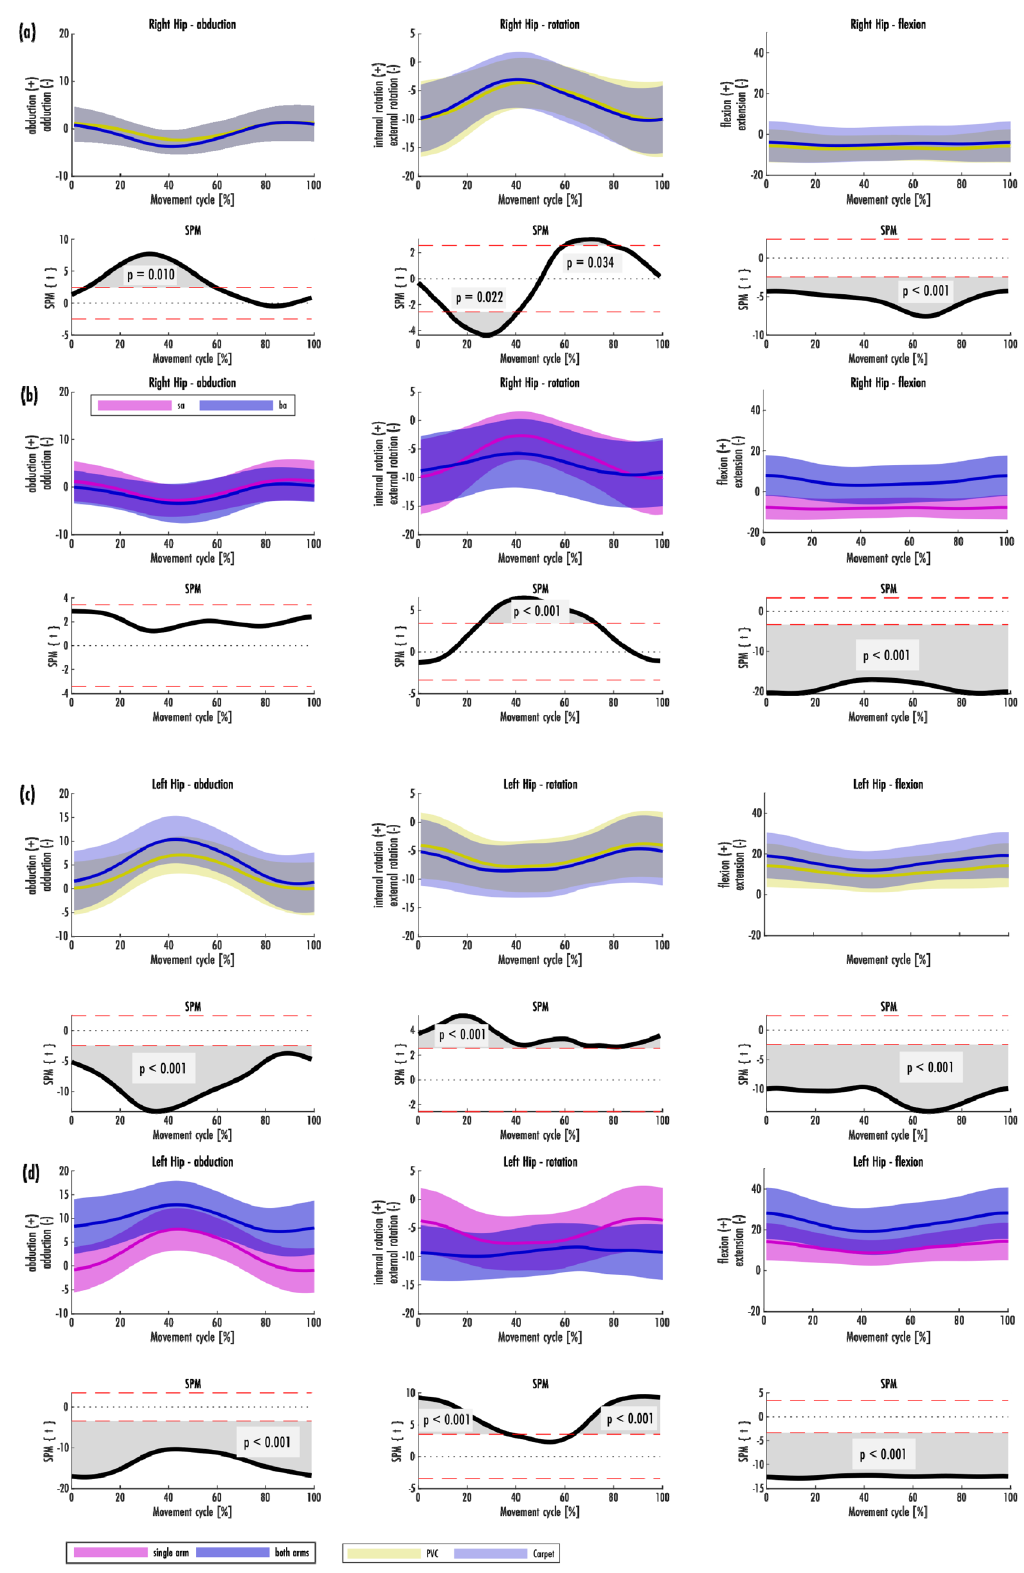
Figure 3. Hip joint movements right ( a , b ) and left ( c , d ) in the habitual vacuuming cycle [Mean and range of standard deviation (± SD)]. ( a , c ) are grouped based on the carpet condition, ( b , d ) are grouped based on the grip position. The result of the SPM is plotted directly underneath the mean and SD of the